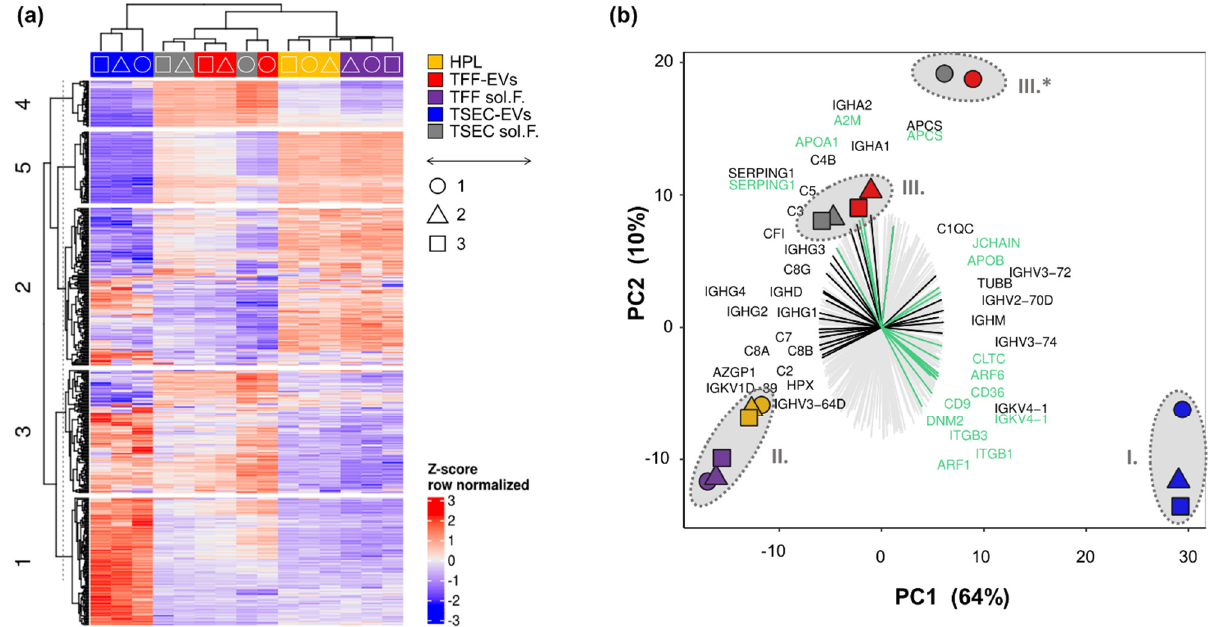
Figure 2. Proteomic profiling of HPL-derived samples. ( a ) Tandem mass-tag (TMT) proteomics of HPL, TFF-EVs, TFF sol.F., TSEC-EVs and TSEC-soluble fractions were analyzed by unbiased clustering in a heatmap indicating five main clusters (1–5, left side). Protein detection levels were row-wise Z-score normalized. Color code as indicated with most replicates grouping together (top) with symbols indicating the three independent experiments ( (cid:52) (cid:3) ). ( b ) Bi-plot including a principal component (PC) analysis and a protein recovery loading plot. Three major clusters composed of ( I. ) TSEC-EVs (blue symbols), ( II. ) HPL + TFF sol.F. (yellow and violet symbols) and ( III. ) TFF-EVs + TSEC-soluble fractions (red and grey symbols, respectively). (III*) Biological replicate 1 differed more in relation to other samples, but was still included within cluster III. Three biological replicates, each performed in three technical replicate runs. A loading plot is also showing the contribution of the 477 detected proteins towards the different clusters. Lines pointing towards a cluster show an enrichment of proteins in this specific cluster. We highlighted in black the “lymphocyte mediated immunity” related proteins and in green the “receptor-mediated endocytosis”